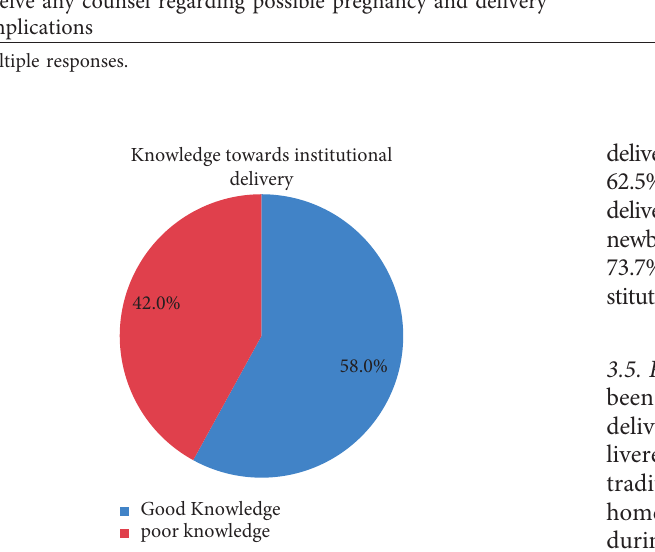
Figure 1: Knowledge of women toward institutional delivery among women who gave birth in the last one year in Serbo,